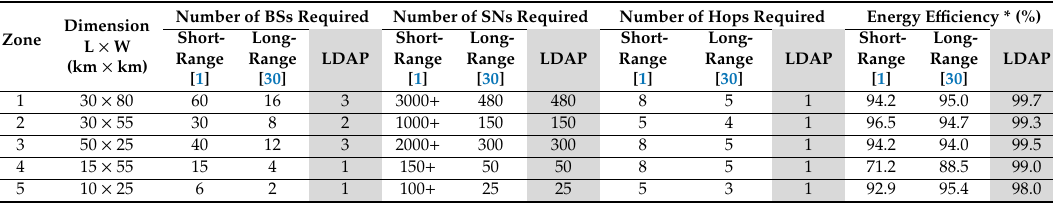
Figure 1. ( a ) Water resource distribution in Northern Saskatchewan with five different zones, ( b ) Wide Wireless Sensor Network (WSN) for water quality monitoring (WQM) for Zone 1. Table 1. WSN requirements for the water resources shown in Figure 1a. LDAP: lightweight dynamic auto-reconfigurable protocol.